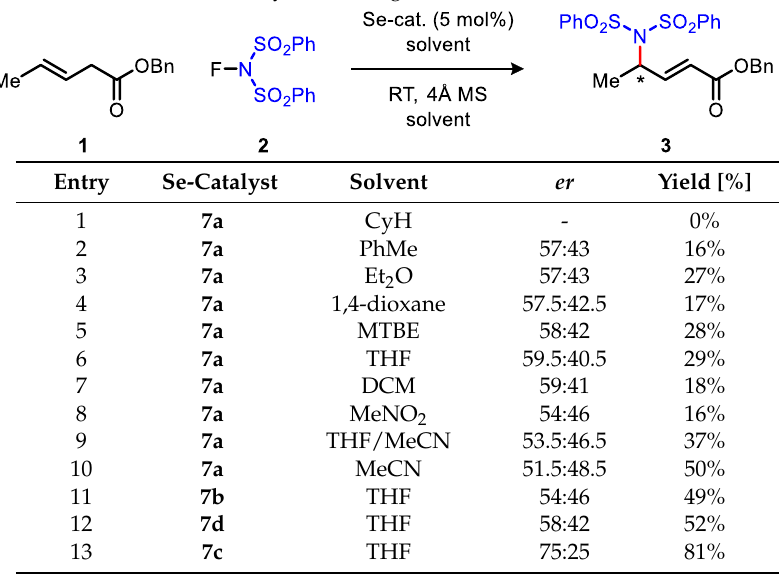
Table 1. Solvent and catalyst screening for the enantioselective imidation.